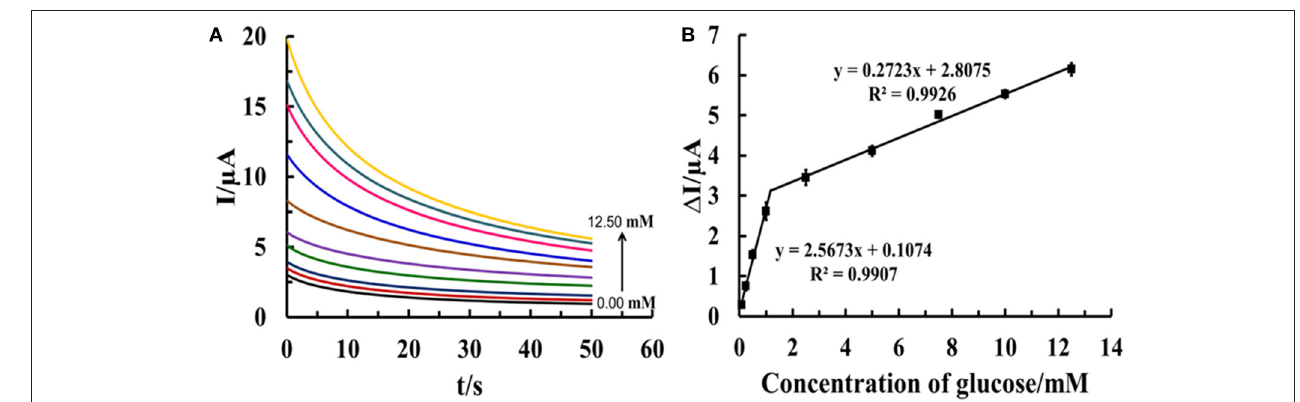
FIGURE 9 | (A) Chronoamperograms from different glucose concentrations (0.10–12.50mM) using Cu(II)/GO-modified electrodes at an operating potential of 0.50V in 0.10M NaOH solution and (B) the corresponding calibration curves of glucose determination.